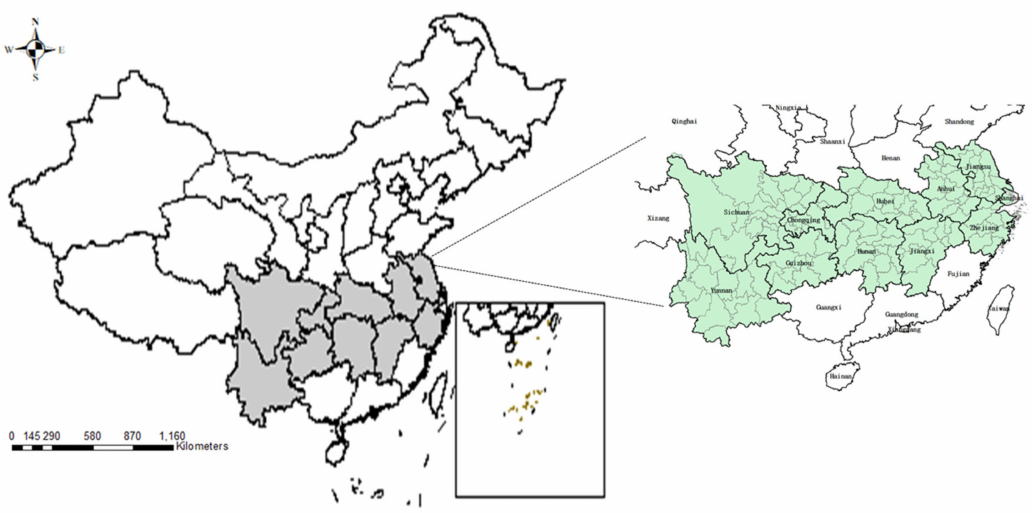
Figure 1. Location of the Yangtze River Economic Zone. Source: Designed by